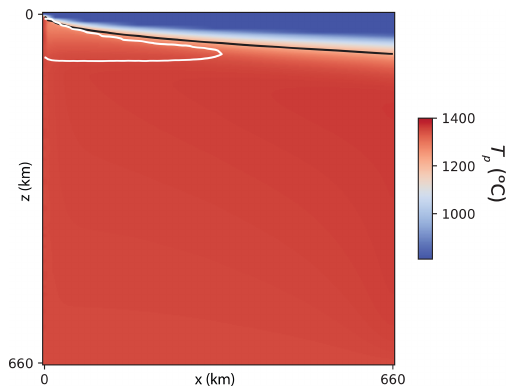
Figure A1. Temperature field and melting for an example mid-ocean ridge model (for description, see “Methods” section). For reference to contour lines, see captions of Figs. 3 and